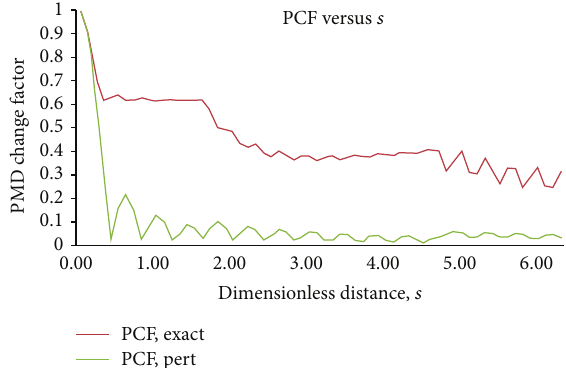
Figure 5: The PCF curves for a nonperturbative limit with Λ = 12 and 𝐿 𝐵 = 1 .